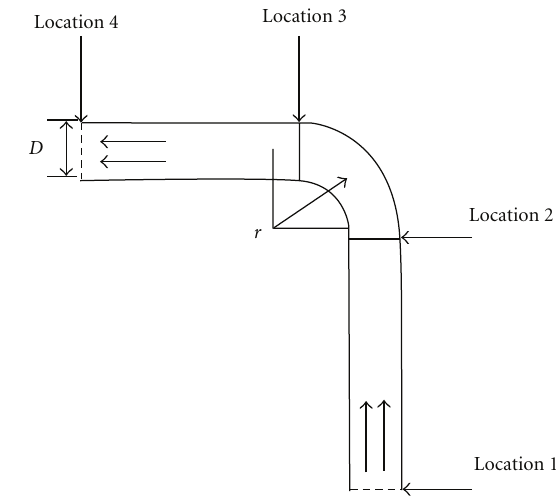
Figure 2: Locations of CFD and experimental